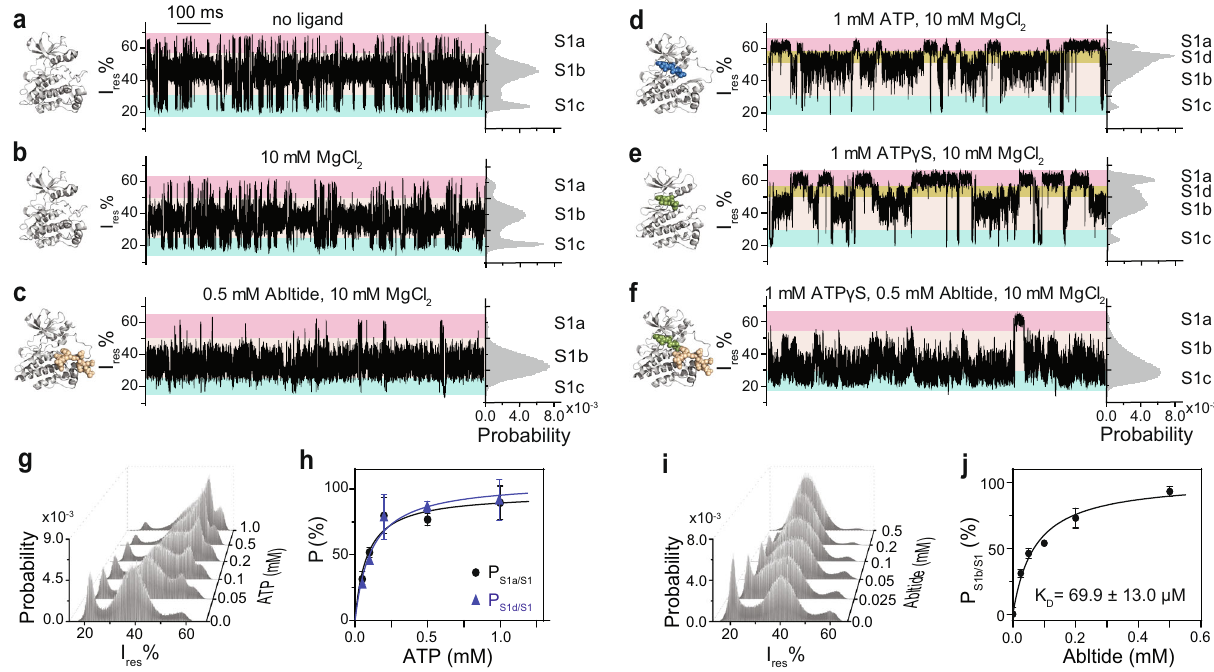
Fig. 2 Interactions of substrates and analogue with N4pos Abl. a – f Structural models, representative traces and corresponding histograms of S1 of apo N4pos Abl ( a ) and N4pos Abl in the presence of 10 mM MgCl 2 ( b ), 0.5 mM Abltide and 10 mM MgCl 2 ( c ), 1 mM ATP and 10 mM MgCl 2 ( d ), 1 mM ATP 10 mM MgCl 2 ( e ), 0.5 mM Abltide, 1 mM ATP γ S and 10 mM MgCl 2 ( f ). Structure models of apo Abl kinase domain and Abl:ATP γ S were produced from PDB 6XR6 and 2G2F respectively. Structural models of Abl:ATP, Abl:Abltide and Abl:ATP γ S:Abltide complexes were generated from PDB 2G1T. Abl, ATP, ATP γ S and Abltide are colored in gray, blue, green and wheat, respectively. S1 sub-states S1a, S1b, S1c and S1d were highlighted with pink, beige, cyan and yellow, respectively. g All points histograms of S1 states at various ATP concentrations. h Determination of K D for ATP binding in two binding modes, S1a (black) and S1d (blue). Data were represented as mean ± SD, n = 3 independent replicates. Source data are provided as a Source Data fi le. i All points histograms of S1 states at various Abltide concentrations. j Determination of K D for Abltide binding. Data were represented as mean ± SD, n = 3 independent replicates. Source data are provided as a Source Data fi le. All current traces were collected at − 80 mV in 150 mM NaCl, 100 mM Tris-HCl, pH 7.5, at 22 increasing the relative occupancy P S1b/S1 (de fi ned as the popula- tion occupancy of S1b relative to S1) from 62.1 ± 2.9% to 93.6 ± 0.3% (Fig. 2c). Interestingly, ATP binding augmented a